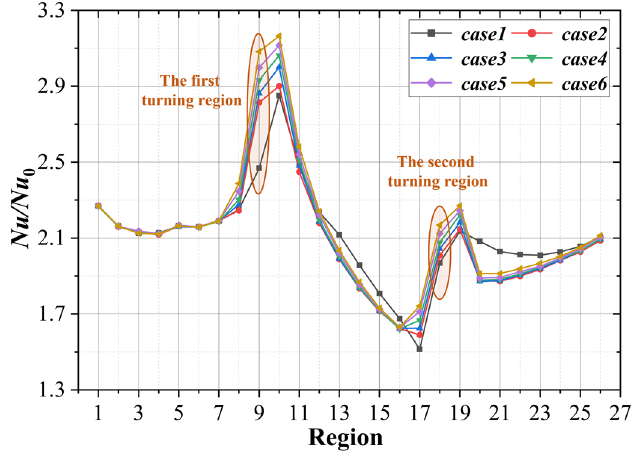
Figure 16. The wall Nu/Nu 0 of RS TR , Ro = 0.4.